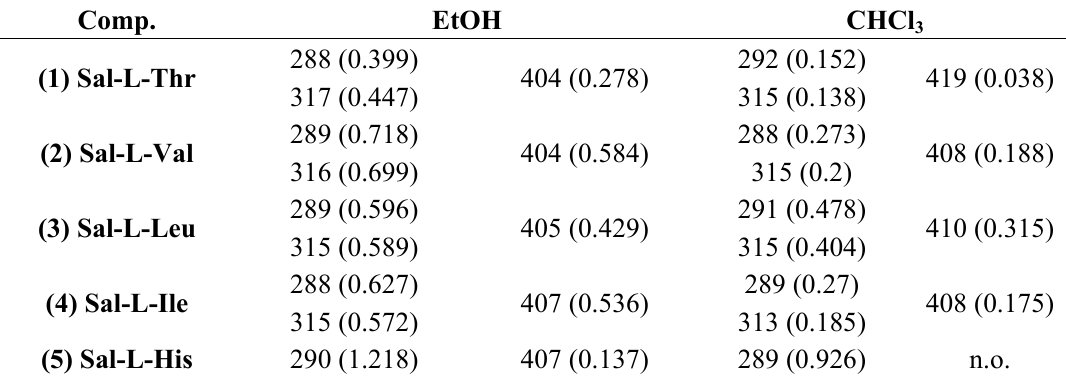
Table 3. UV-Vis bands of compounds 1 – 5 in ethanol and chloroform solution (nm). In parentheses absorbance